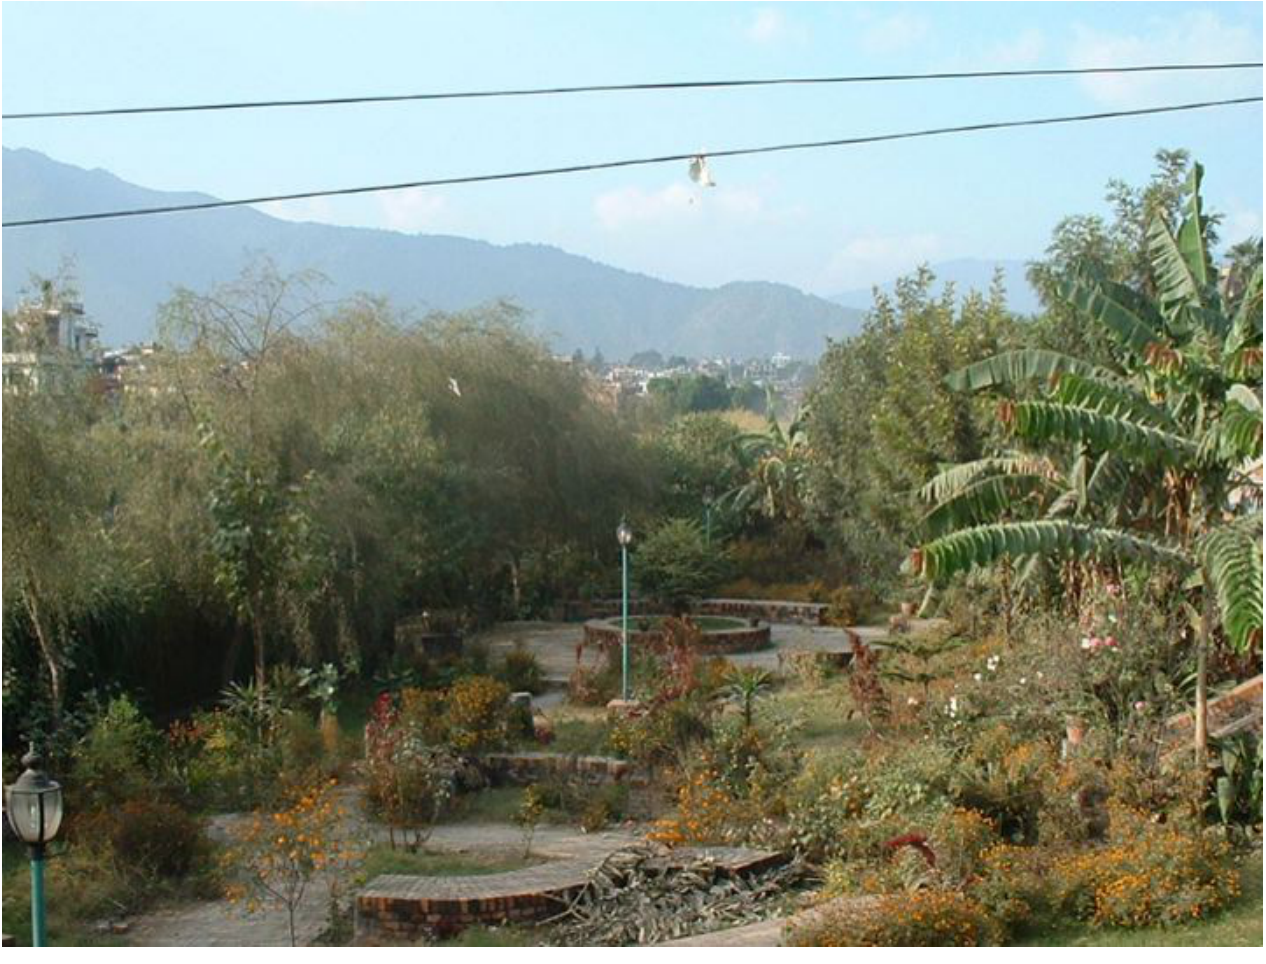
Fig. 11 . The bank of the Bishnumati River adjacent to Wards 19 and 20, Kathmandu,